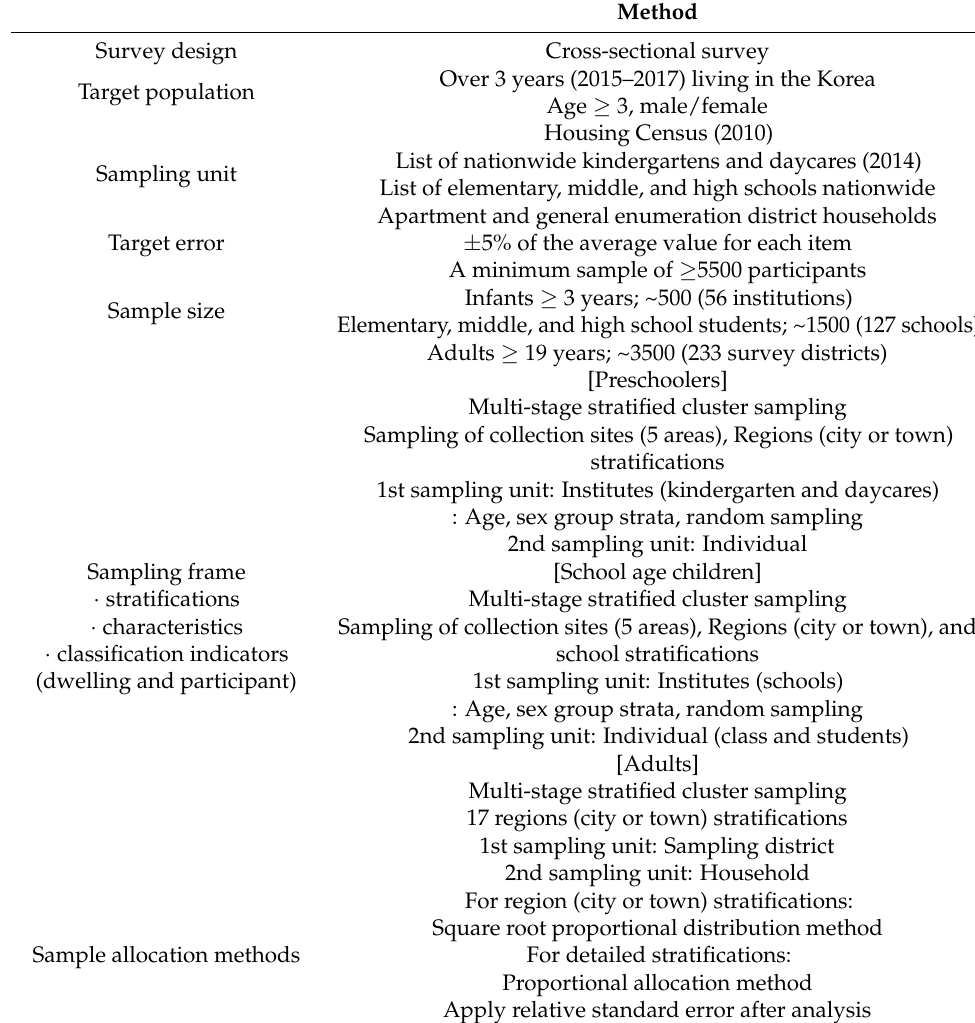
Table 1. Survey sample design details of the KoNEHS Cycle 3